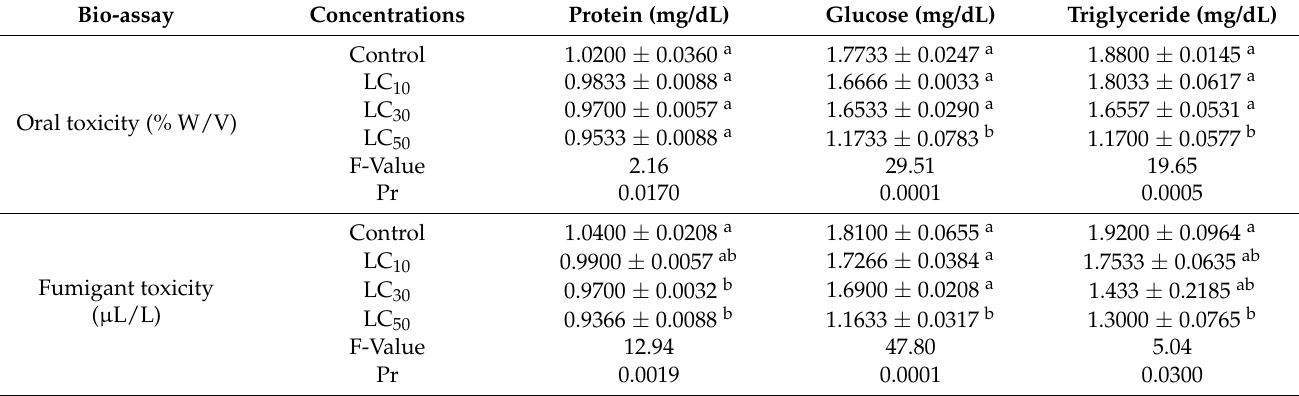
Table 3. Effect of Artemisia annua flowers’ essential oil on macromolecules in 4th instar larvae of Glyphodes pyloalis .